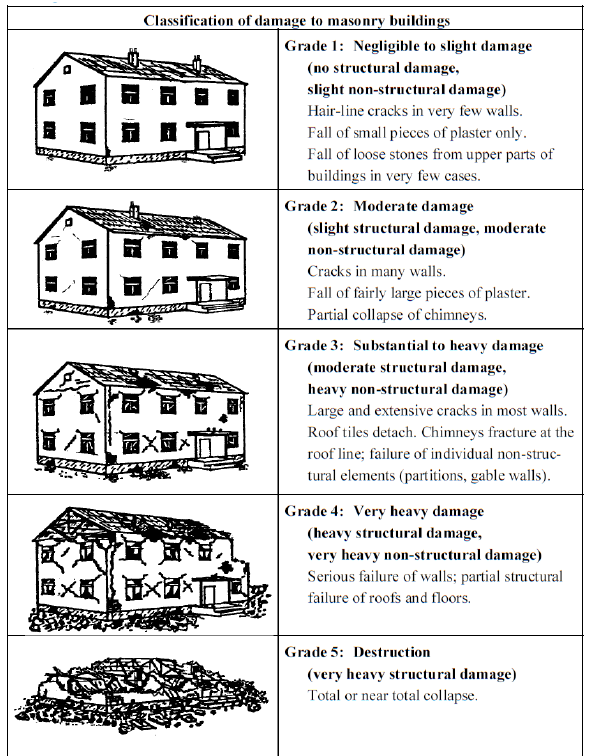
Figure 2. Classification of damage to masonry buildings of EMS-98.